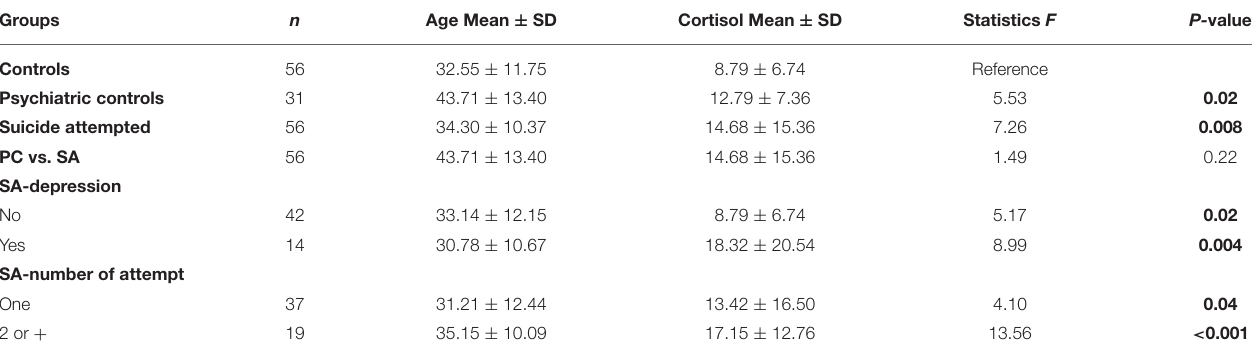
TABLE 4 | Level of plasma cortisol ( µ g/dL) in subgroups of suicide attempters and comparison groups (health and psychiatric group) in a Mexican population.